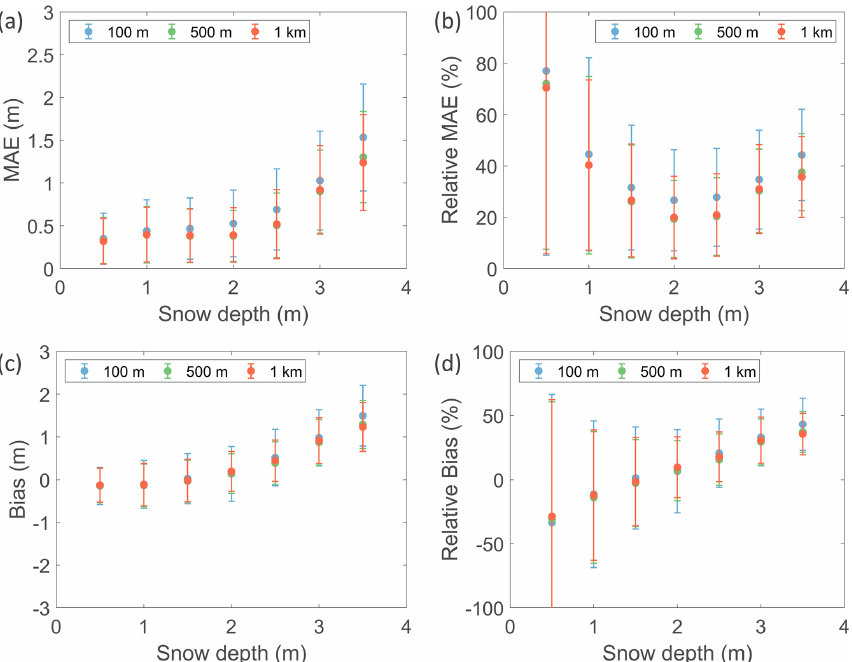
Figure 13. The (a) MAE (m), (b) relative MAE (%), (c) bias (m), and (d) relative bias (%) between 100m, 500m, and 1km S1 retrievals and in situ measurements for August through April 2017–2018 and 2018–2019. Bars indicate ± 1 standard deviation. Wet snow detected by S1 is excluded. The metrics are stratified by the measured snow depth value (not by the range as in Fig. 12), with intervals of